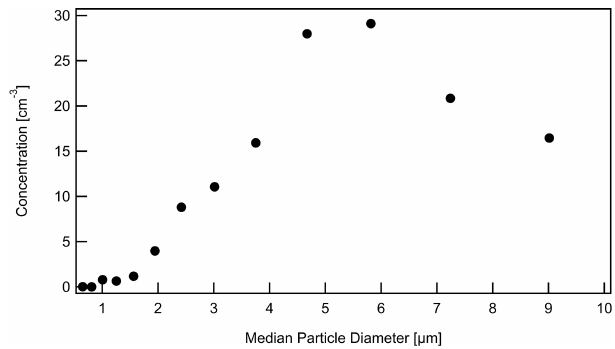
Figure 6. Ice crystals’ concentration at the outlet of the evaporation chamber as a function of the optical particle diameter.